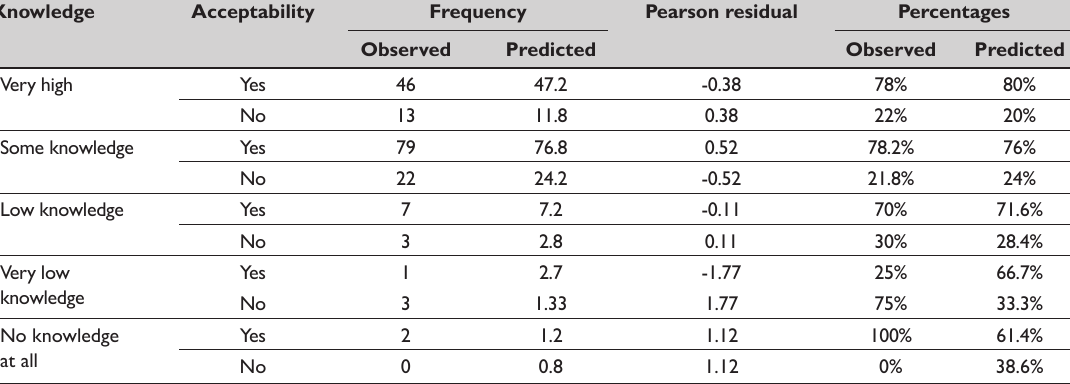
Table 4: Observed and predicted frequencies for the association between HIV knowledge and the willingness to accept HIV screening